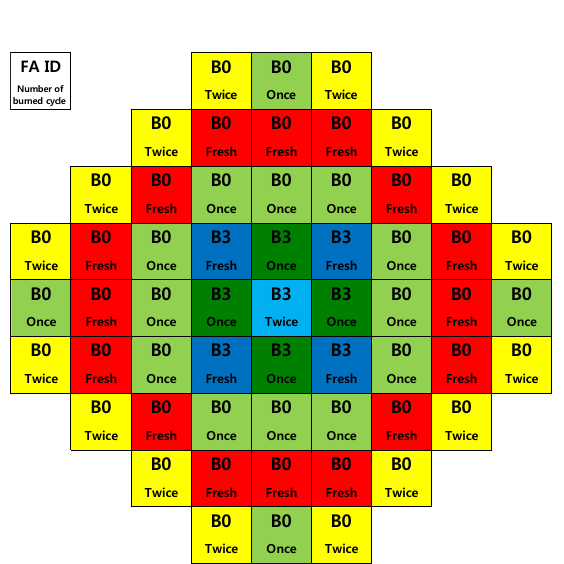
Figure 4. Core loading pattern of 5 th equilibrium cycle at BOC